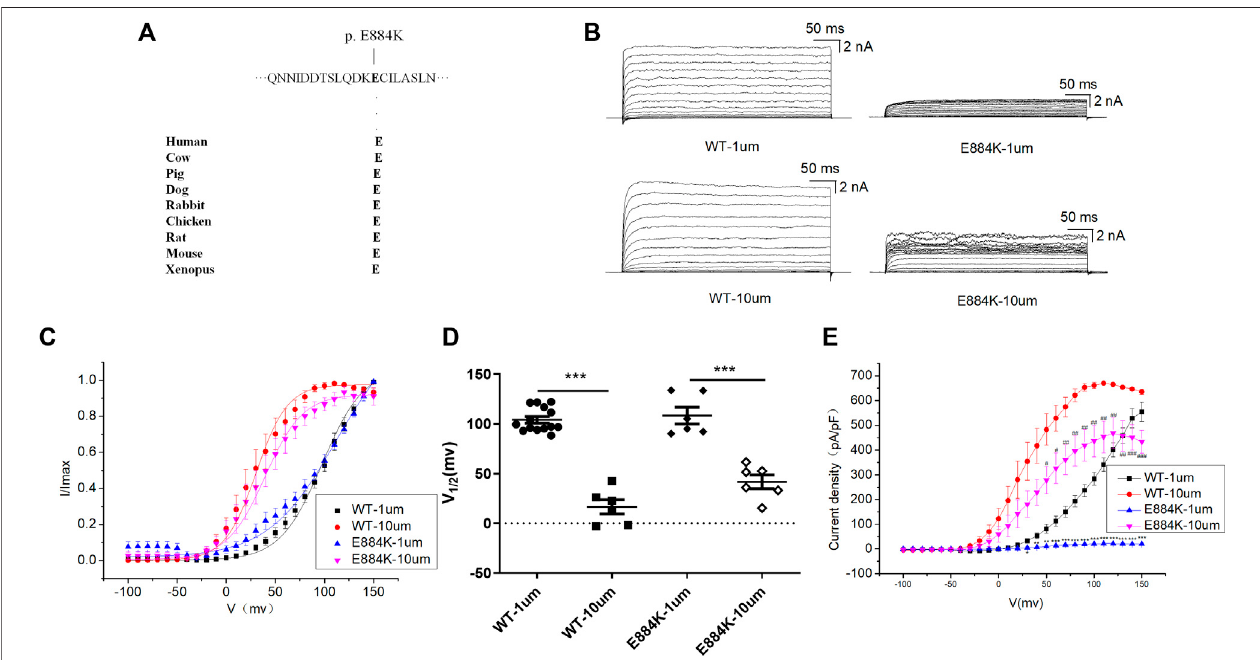
FIGURE 4 | Electrophysiological characterization of variant E884K. (A) The E884K variant occur at an evolutionarily conserved amino acid residues. (B) Representative macroscopic currents of WT and mutant BK channels with variant E884K from whole-cell patch experiments in the presence of 1 and 10 μ m Ca 2+ . (C) The I-V curves of WT and E884K mutant BK channels are shown at 1 and 10 μ m Ca 2+ . The I-V curves are fi tted by Boltzmann function (solid lines) with V1/2 and slope factor at nominal at 1 μ m Ca 2+ [97.5 ± 4.1 mV, 21.4 ± 2.1 WT, and 112.0 ± 6.7 mV, 34.8 ± 4.2 p.(E884K)] and at 10 μ m Ca 2+ [30.4 ± 2.4 mV, 15.9 ± 0.8 WT, and 39.3 ± 2.2 mV, 19.3 ± 1.4p.(E884K)]. (D) Scatterplots ofvoltage at half-maximal activation (V1/2) for WT and variants. (E) The current density ofWT and E884K mutant BKchannelsareshownat1and10 μ mCa 2+ .Thedataarepresentedasmean ± SEM.(ComparedwithWT-1um,* p < 0.05,** p < 0.01,*** p <